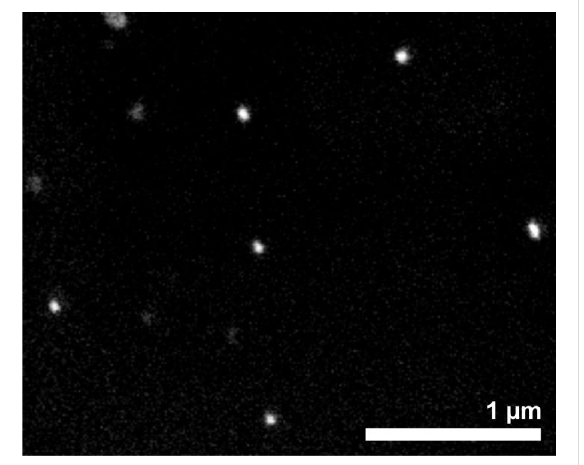
Figure 8: SEM image of the chemisorbed gold nanoparticles on the aminopropylated Si[111]